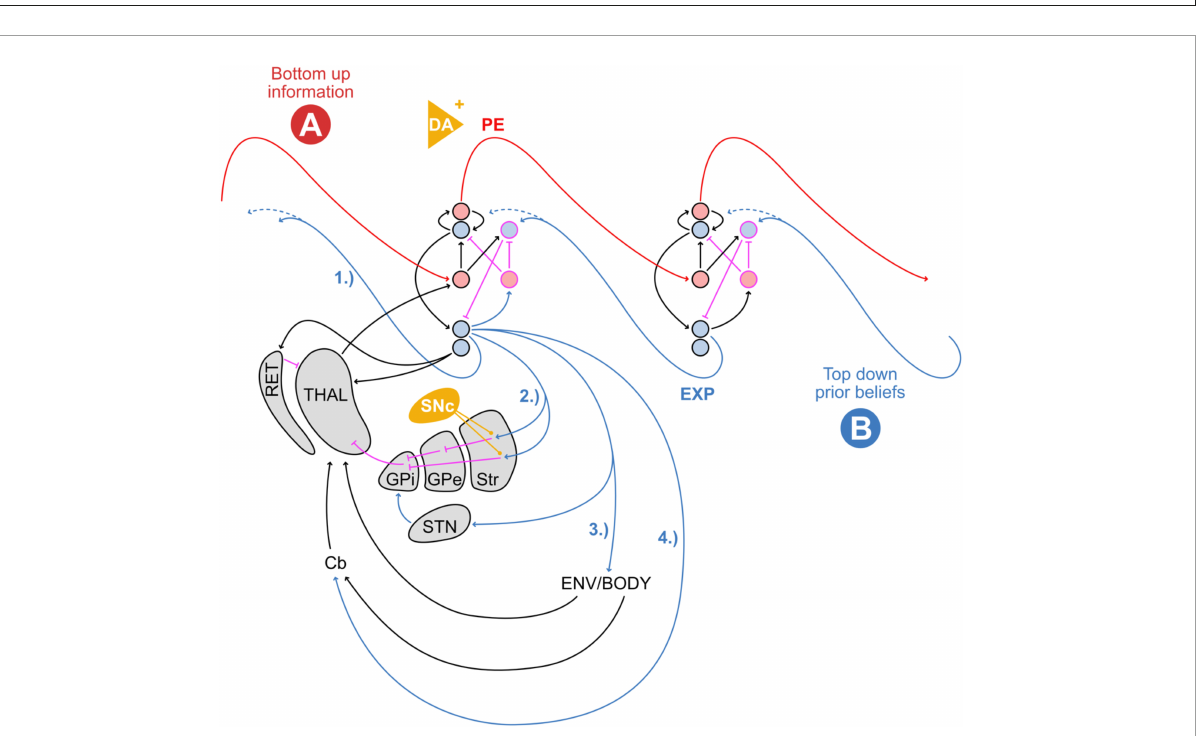
FIGURE5 Schema of hierarchical cortical connections depicting several types of top-down prior expectations (EXP) from deep layer pyramidal neurons: (1) to lower cortical levels, (2) to the basal ganglia loops, (3) to the body and environment via the pyramidal tract, and (4) to the cerebellum in the form of an efference copy. The feedback from both the body and the environment arrives at the thalamus, where it is weighted by and integrated with basal ganglia signals at the level of the thalamocortical system. Striatal dopamine (orange ovoid) facilitates basal ganglia output and increases the precision of prediction errors (Friston K. J. et al., 2012). Cortical dopamine (orange triangle) modulates presynaptic input strength by influencing Hebbian plasticity (Isomura, 2021). Red: feed-forward, blue: feedback, black: other excitatory, pink: